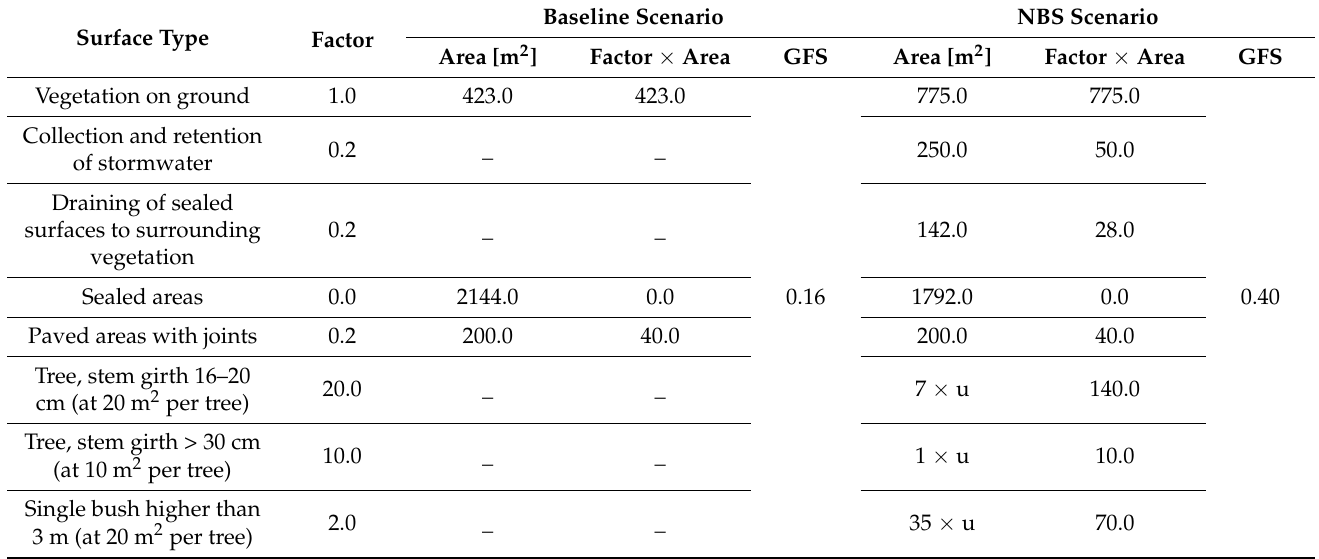
Table 6. The results of GSF